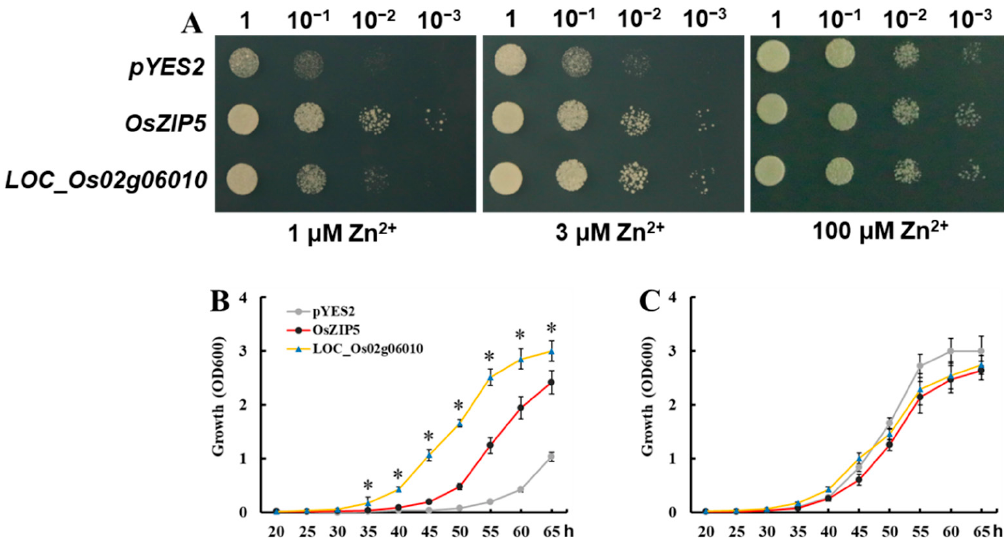
Figure 5. Complementation of the yeast mutant strain ZHY3 by LOC_Os02g06010. ( A ) Overnight yeast cell suspensions of ZHY3 transformed with empty vector pYES2, OsZIP5, or LOC_Os02g06010 were serially diluted (1:10) and spotted onto solid media containing 1, 3 or 100 µ mol/L ZnSO 4 . Pictures were taken after three days growth at 30 ◦ C. Yeast strains were grown in liquid media with ( B ) 3 µ mol/L ZnSO 4 or ( C ) 100 µ mol/L ZnSO 4 for 65 h. The absorbance at 600 nm (OD 600 ) of cell cultures was measured every 5 h. Values are mean ± SE ( n = 3). The asterisks (*) above the bars indicate significant difference between lines at p < 0.01.